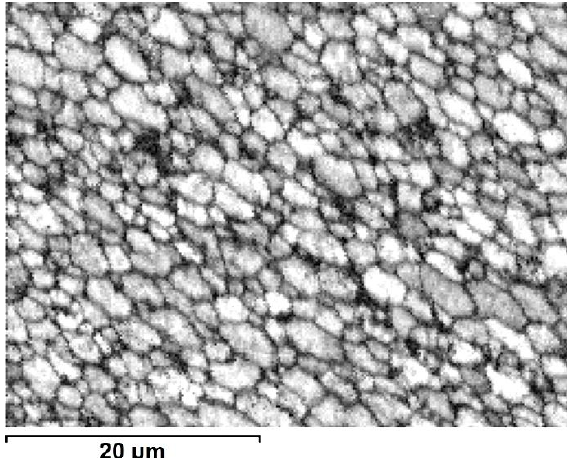
Figure 12. Image based on quality ratio of electron diffraction pattern (SEM/EBSD) from outer-zone area (E/224 rpm).